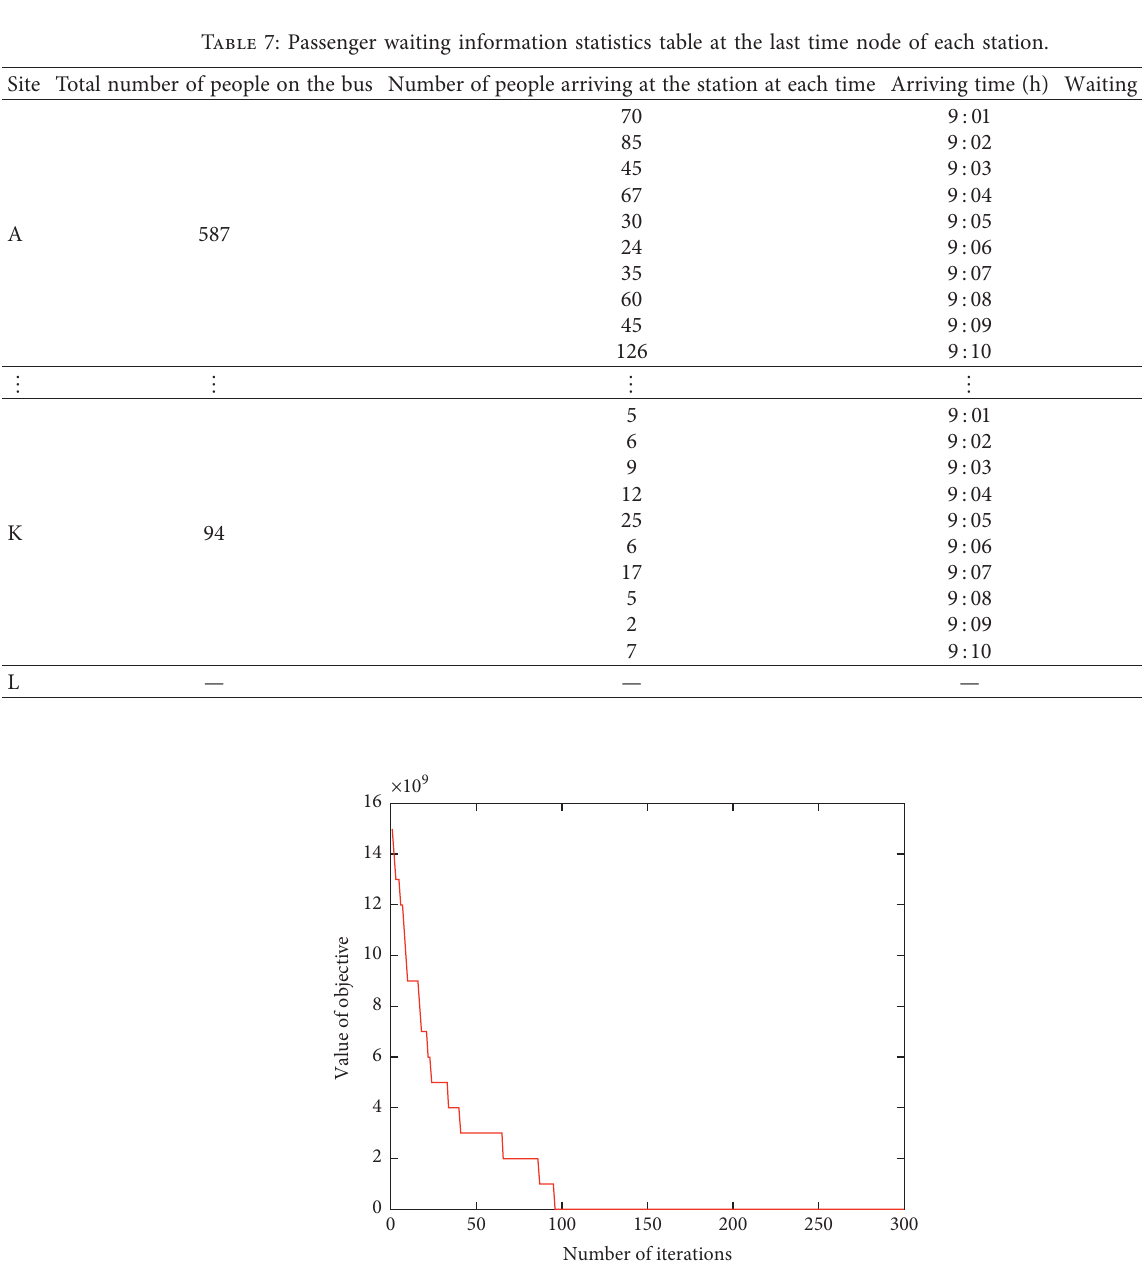
Figure 8: The optimal value iteration